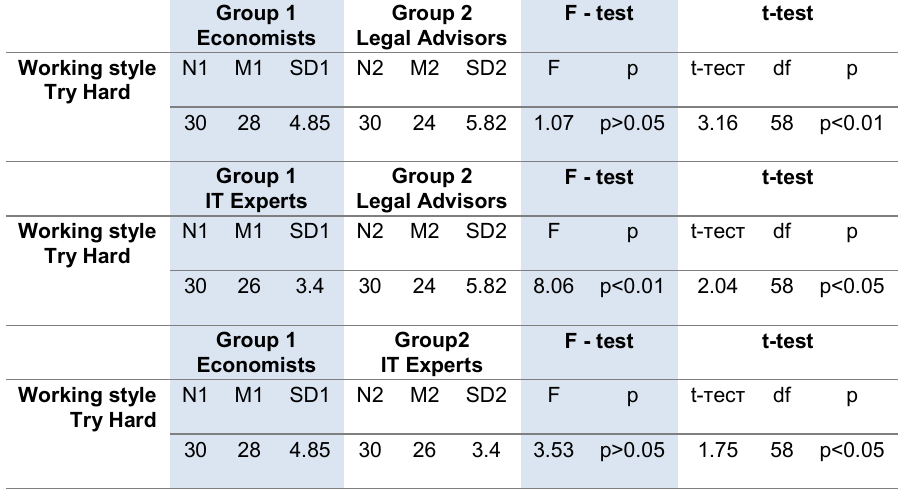
Table 6: Analysis of the differences between the three professions regarding the working style Try Hard Group 1 Group 2 F - test Economists Legal Advisors